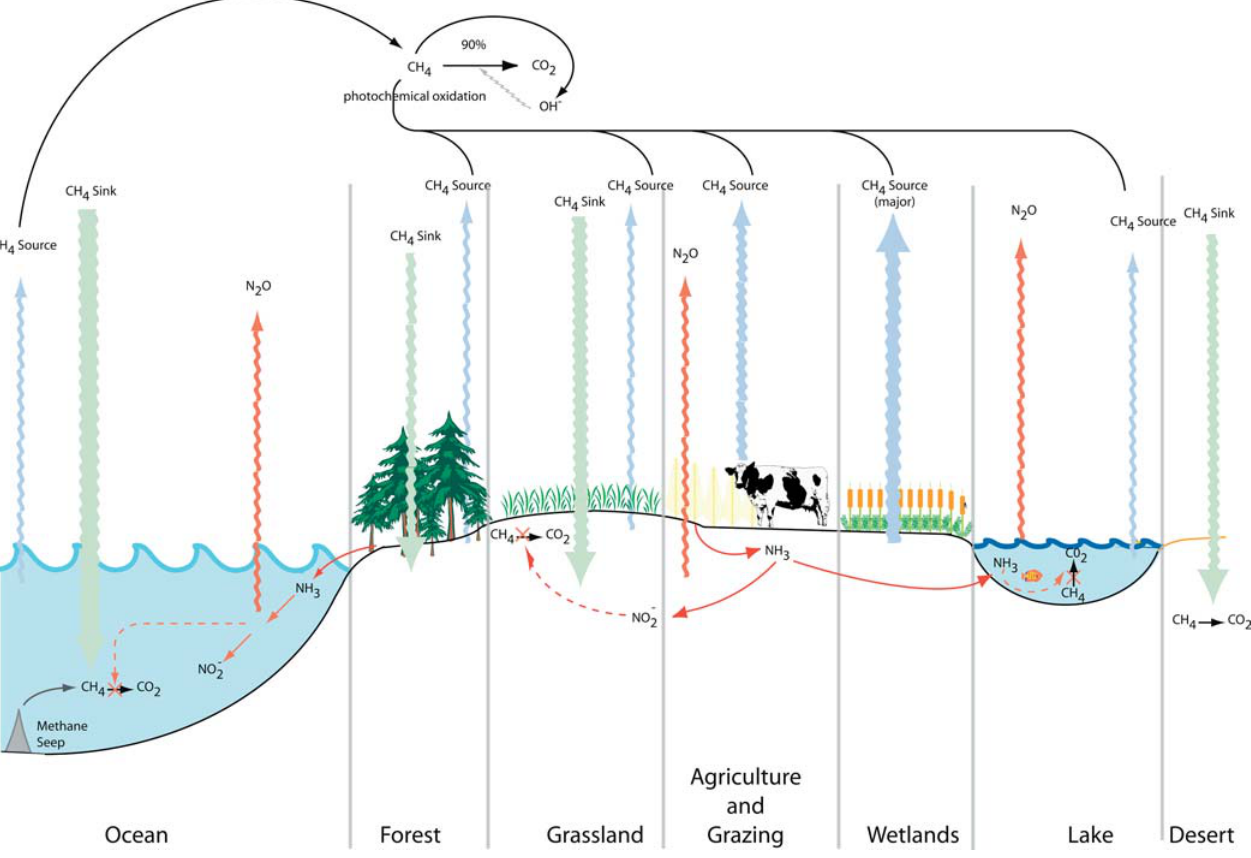
Figure 1. Global Methane Cycle Methane is oxidized either photochemically in the atmosphere or biologically in terrestrial and aquatic systems. The ocean, grasslands, and desert form major methane sinks, whereas wetlands, agricultural and grazing lands, and other anthropogenic sources such as landfills, are major sources. The cow depicted in the figure represents diverse ruminants. Anthropogenic inputs of nitrogen in the form of ammonia compete for MMOs, reducing methane oxidation and leading to the formation of nitrous oxide, another greenhouse